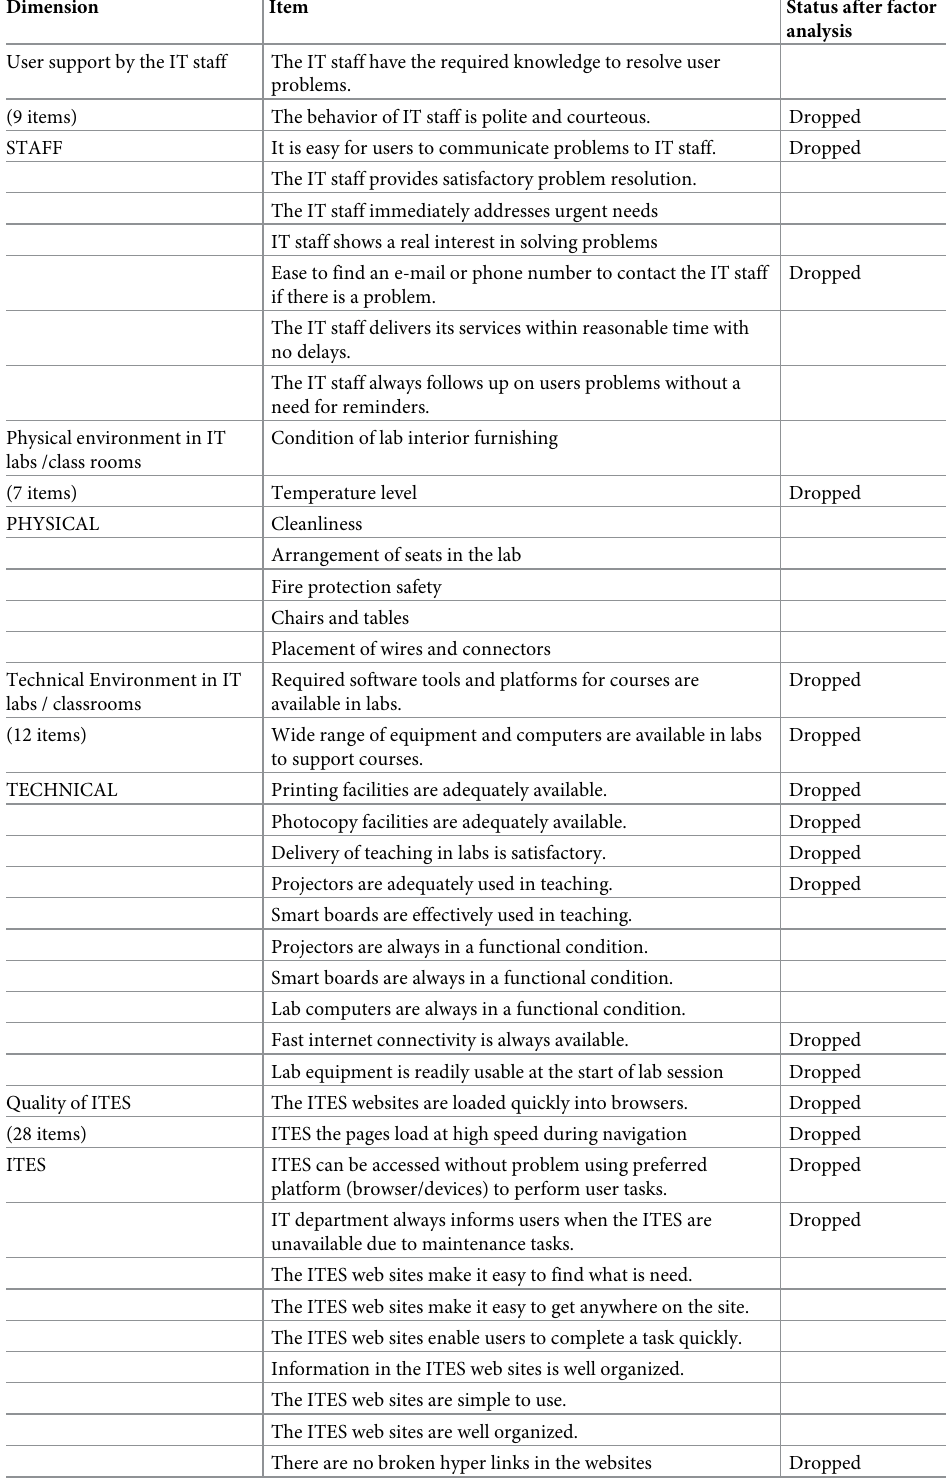
Table 2. Identified factors and